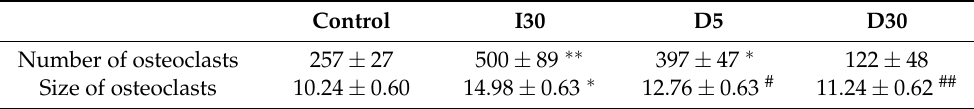
Table 5. Number and size of differentiated osteoclasts by TRAP and actin ring staining (mean ± SD). Control I30 D5 Number of osteoclasts